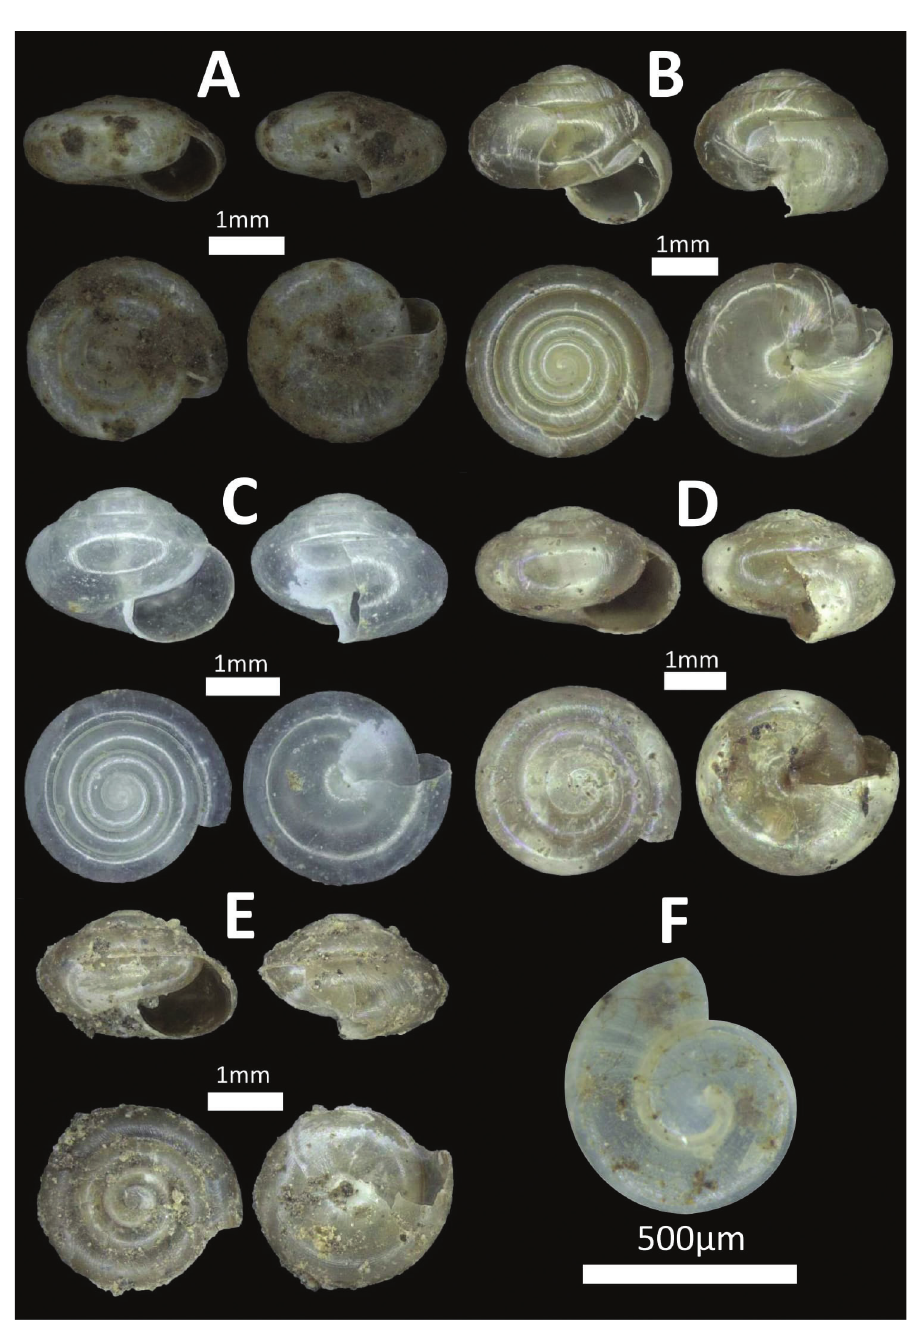
Figure 12. Family Ariophantidae. A Microcystina callifera (BOR/MOL 7176) B Microcystina physotrochus (BOR/MOL 8457) C Microcystina physotrochus (BOR/MOL 857) D Microcystina muscorum (BOR/MOL 8920) E Microcystina sp. 1 (BOR/MOL 1286) *Probably juvenile F Microcystina sp. 2 (BOR/MOL 10352) *Broken